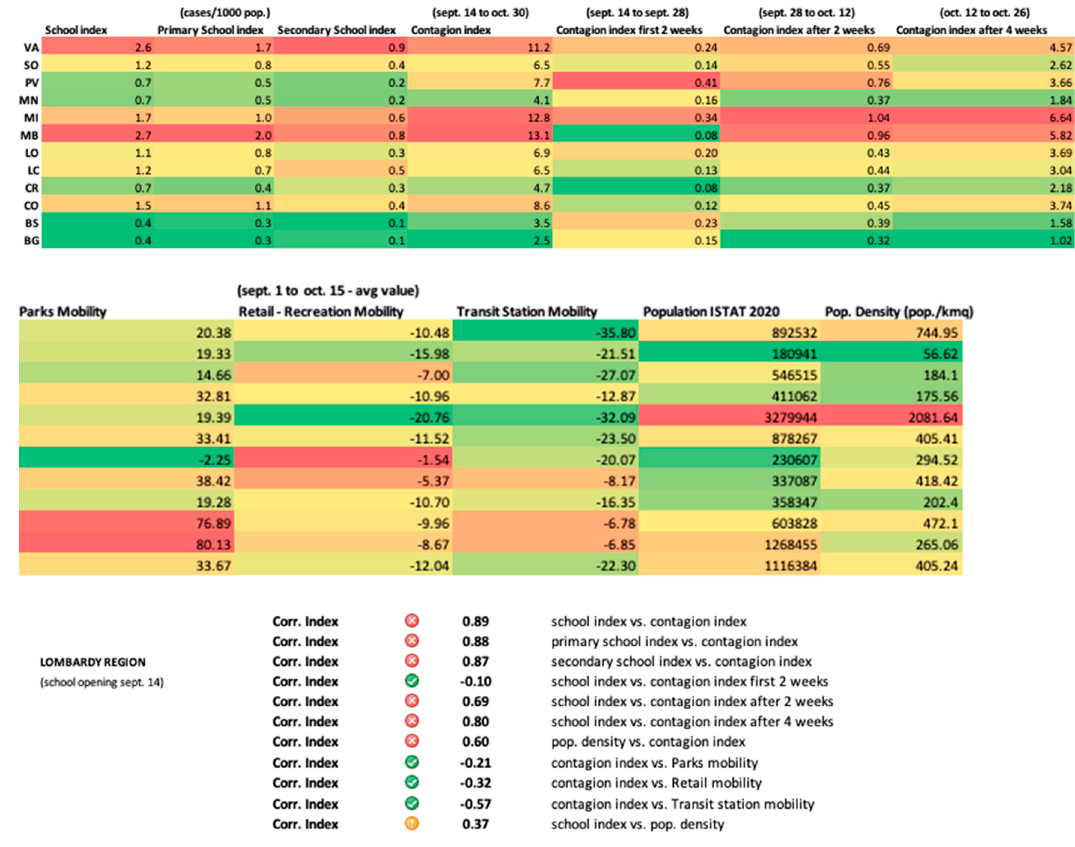
Figure 2. Lombardy Region data set for School contagion Index and overall contagion. Correlation study.